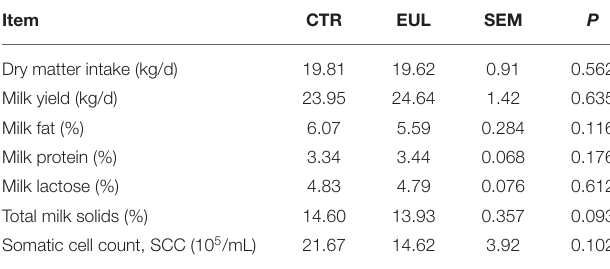
TABLE 3 | Biochemical indicators, hormone concentrations, and immune parameters in milk ( n =